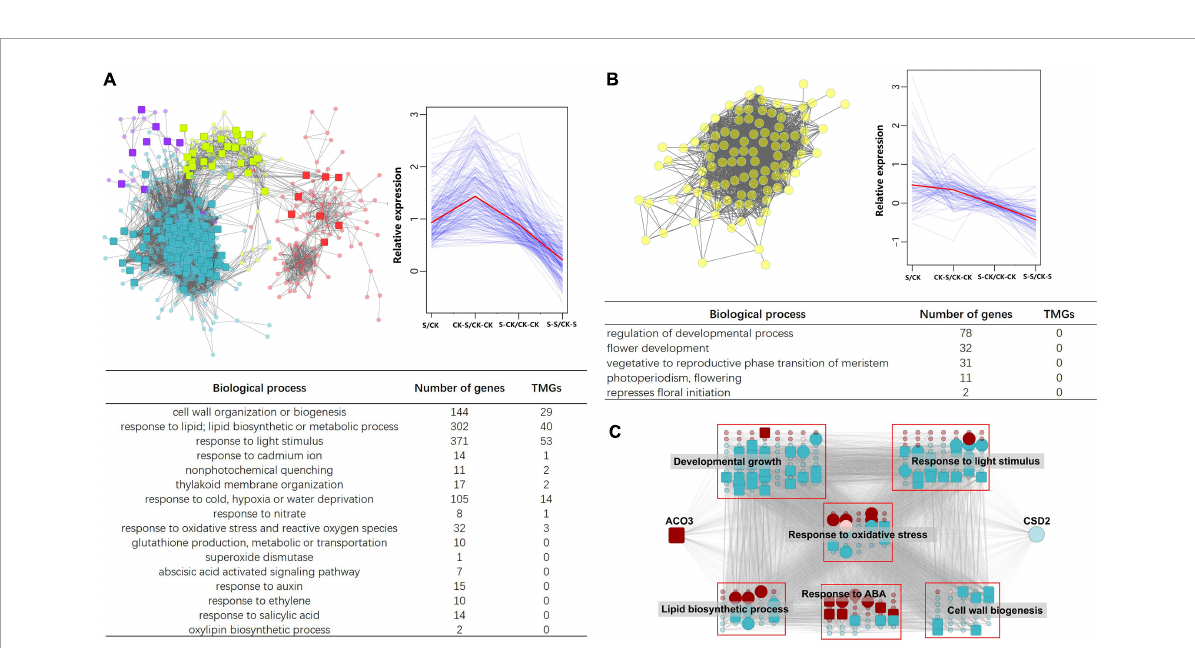
FIGURE7 The TMGs in trait-related modules. (A) TMGs that participate in Cd stress adaptation and are co-expressed with other important genes in a sub-network of four modules (turquoise, red, greenyellow, and purple) that are correlated with Cd treatment, GSH, and SOD. Pictures showing the expression pattern of TMGs and its co-expression relationship with other genes. Function and corresponding gene numbers are listed at the bottom. (B) Gene co-expression relationship, expression pattern, and function in the yellow module, which is highly correlated with flowering time. No TMGs were identified in this module. (C) Sub-network formed by ACO3 , CSD2 , and their neighbors. Different nodes are classified according to gene function. For simplicity, neighbors of the other functions are not shown. Key hub genes are represented by larger circles, TMGs are represented by large squares, and modules that the gene belongs to are represented by different